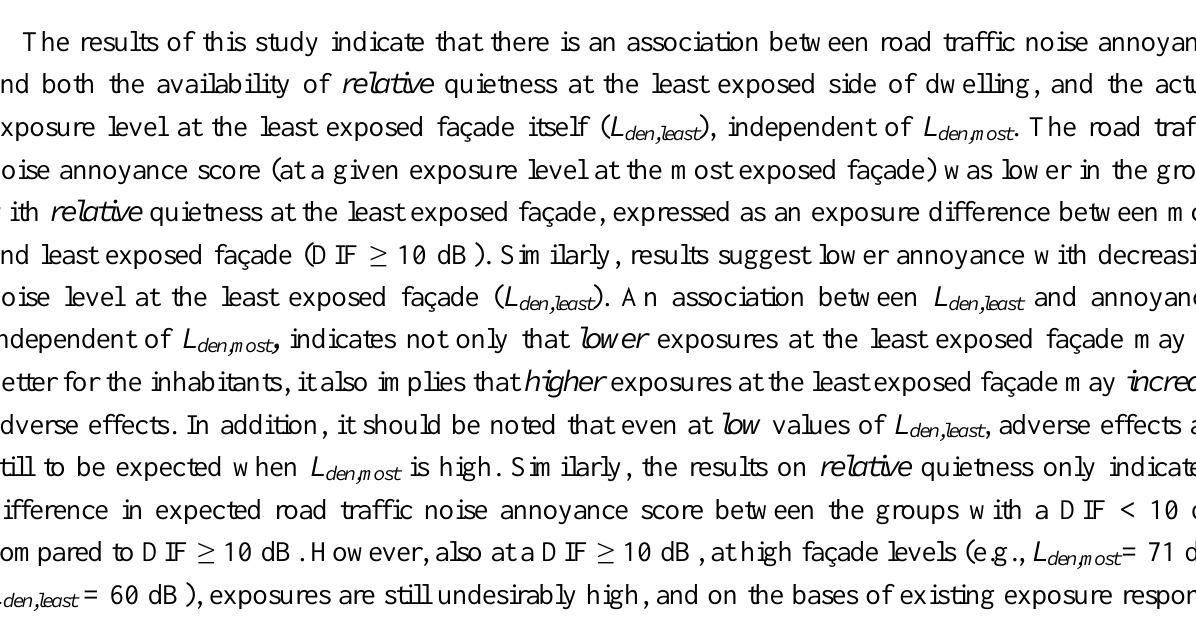
(dB, continuous) and den,most